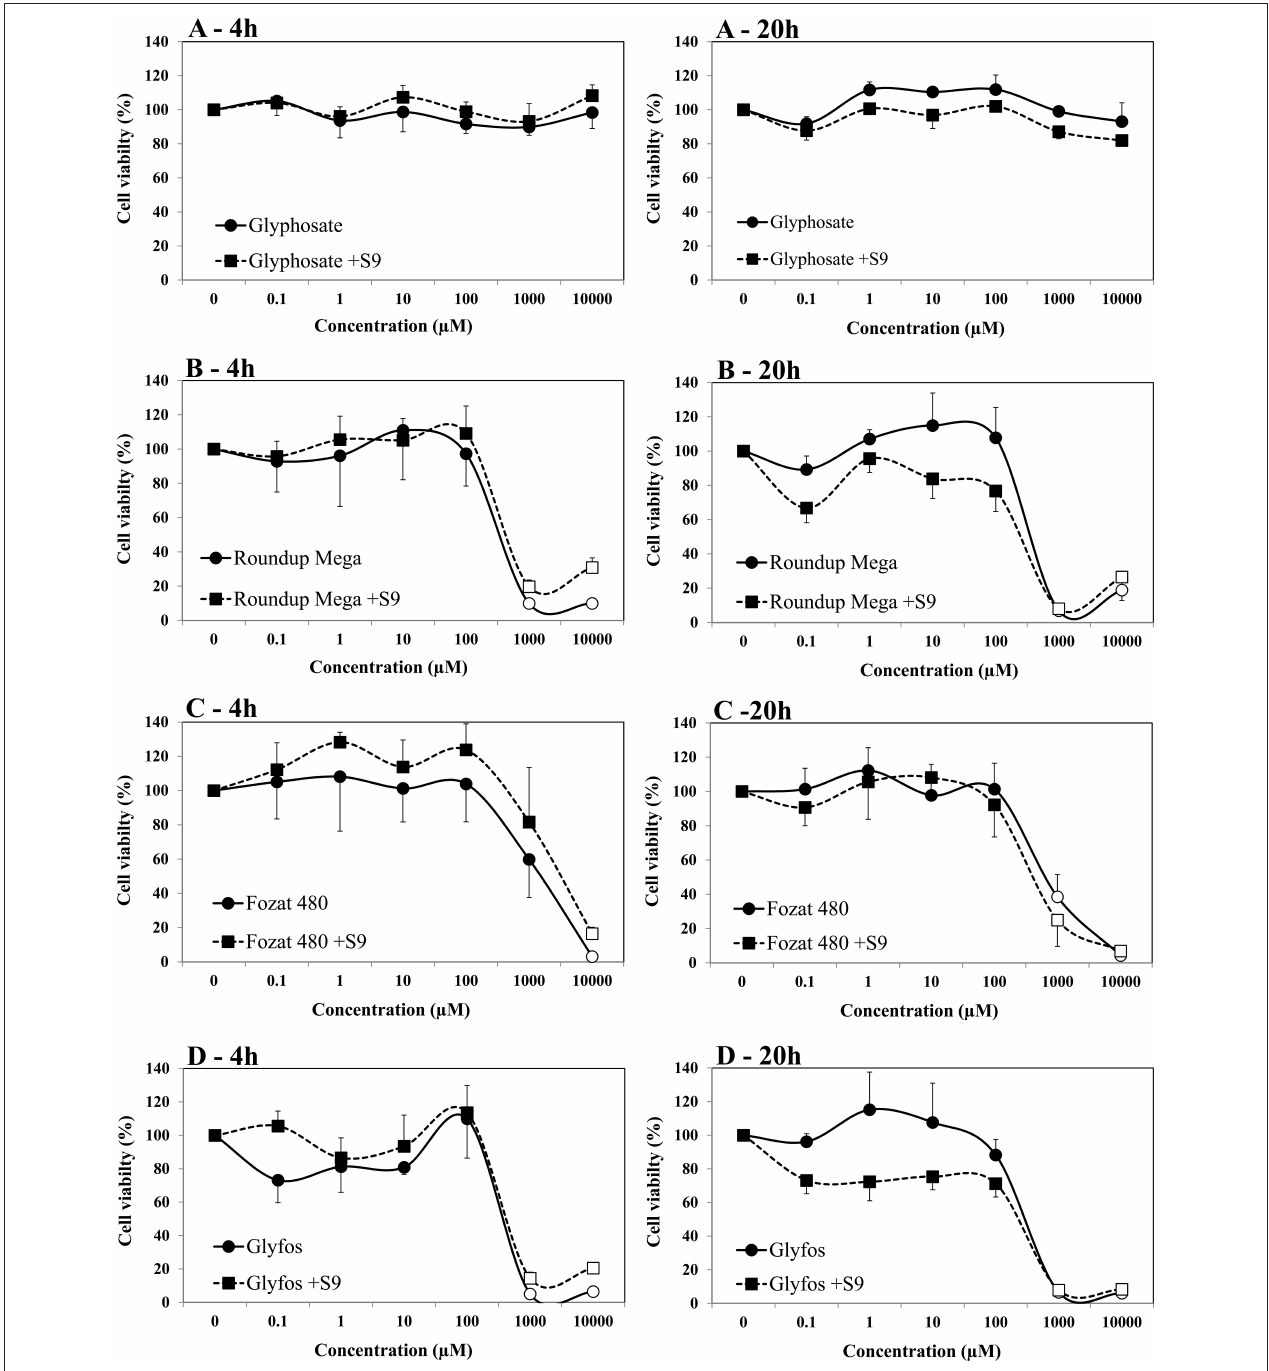
FIGURE 2 | Effect of 4- and 20-h exposure to increasing concentrations of glyphosate (A) , Roundup Mega (B) , Fozat 480 (C) , and Glyfos (D) on cell viability in the absence and presence ( + S9) of metabolic activation system detected by WST-1 cell viability assay. The data points indicate the means ± standard error of the mean (SEM) of three repeated experiments. Statistically significant decrease of cell viability, indicated by empty data points, was determined by comparing the values induced by various doses of glyphosate or GBHs to the background level of untreated cells by ANOVA with Dunnett’s post hoc test.